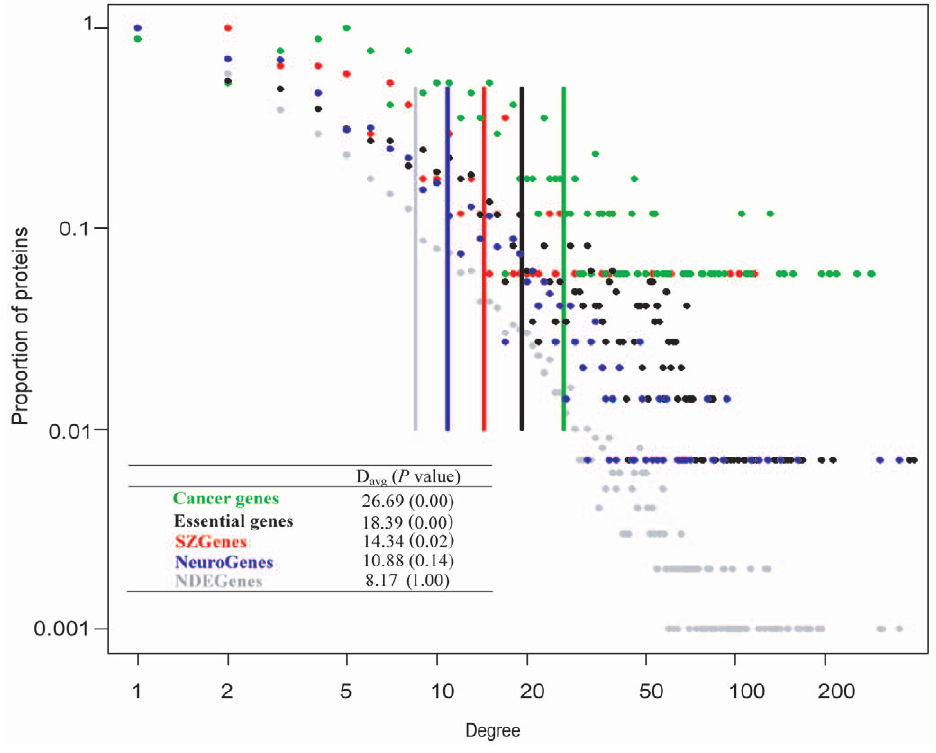
Figure 1. Degree distributions and average degrees (vertical lines) of five gene sets. The Y-axis represents the proportion of proteins having a specific degree. The empirical P value in the inserted table indicates whether the observed average degree in a gene set is random from the human interactome.